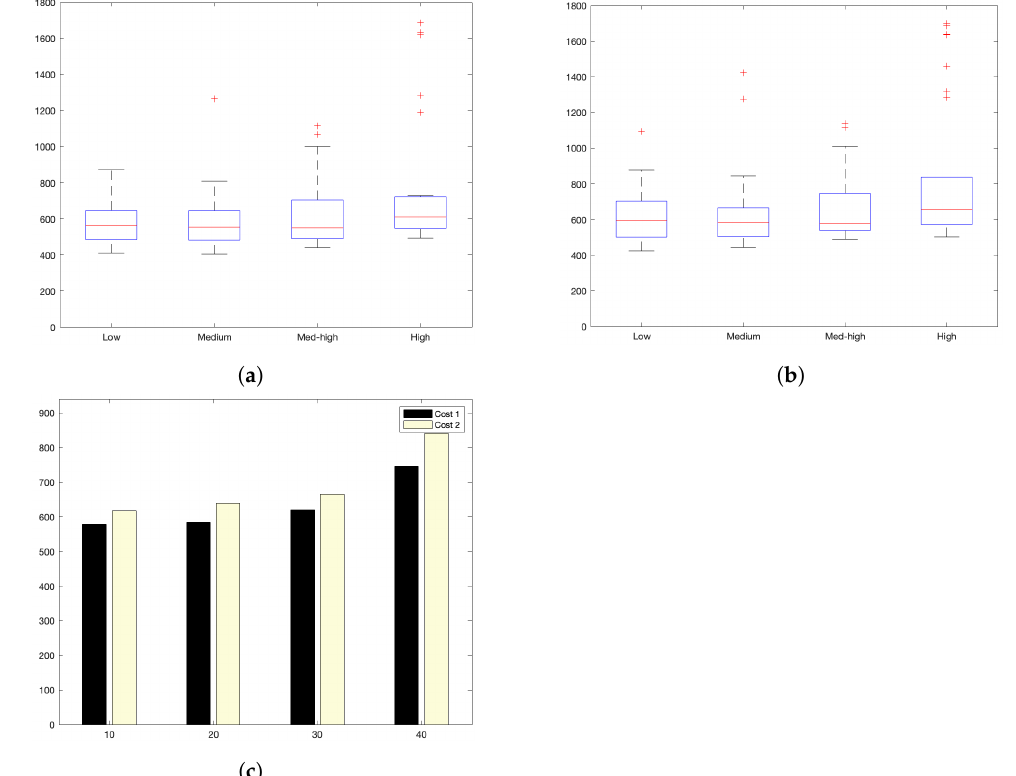
Figure 9. Summary of result analysis from all experiments on all scenarios from the cloud-online architectural perspective. ( a ) Summary of cost 1 . ( b ) Summary of cost 2 . ( c ) Average times for cost 1 and cost 2